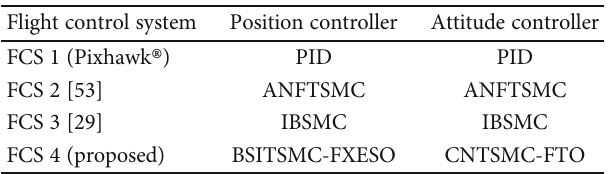
Table 2: Flight control systems compared for the Cartesian trajectory